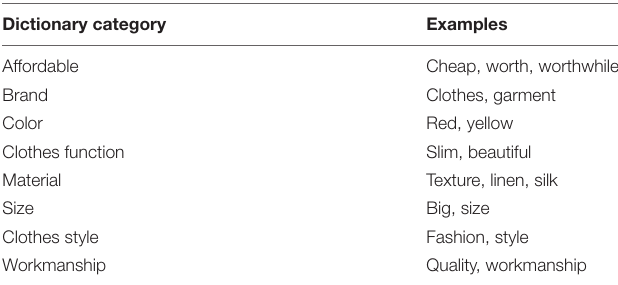
TABLE 2 | Product content category used to calculate language style matching